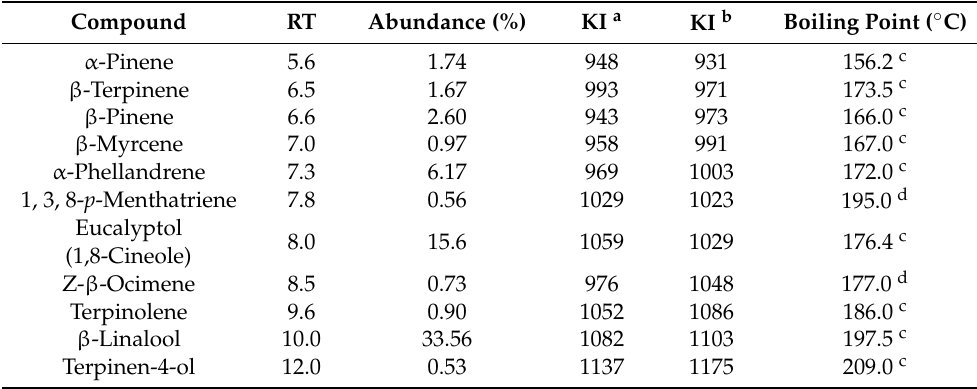
Table 1. GC-MS chemical composition of the essential oil from L. philipiana